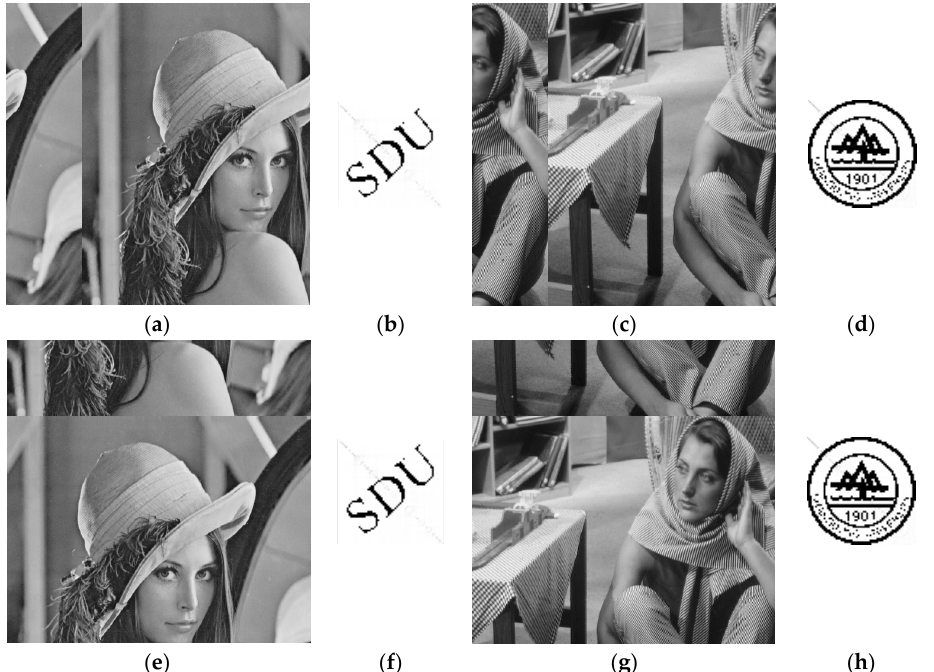
Figure 18. Watermarked images and extracted watermarks under translation attacks: ( a ) horizontally translated Lena (128 pixels); ( b ) extracted watermark w 1 ; ( c ) horizontally translated Barbara (128 pixels); ( d ) extracted watermark w 2 ; ( e ) vertically translated Lena (128 pixels); ( f ) extracted watermark w 1 ; ( g ) vertically translated Barbara (128 pixels); ( h ) extracted watermark w 2 . Table 2 gives the robustness performance of the proposed scheme on two sets of host images and watermarks. Lena image and character watermark are given in the first column, and Barbara image and logo watermark are given in the second column. The PSNR value of the proposed method is 54.6 dB, which expresses good imperceptibility of the watermarked image. Table 2. Robustness performance of the proposed scheme.